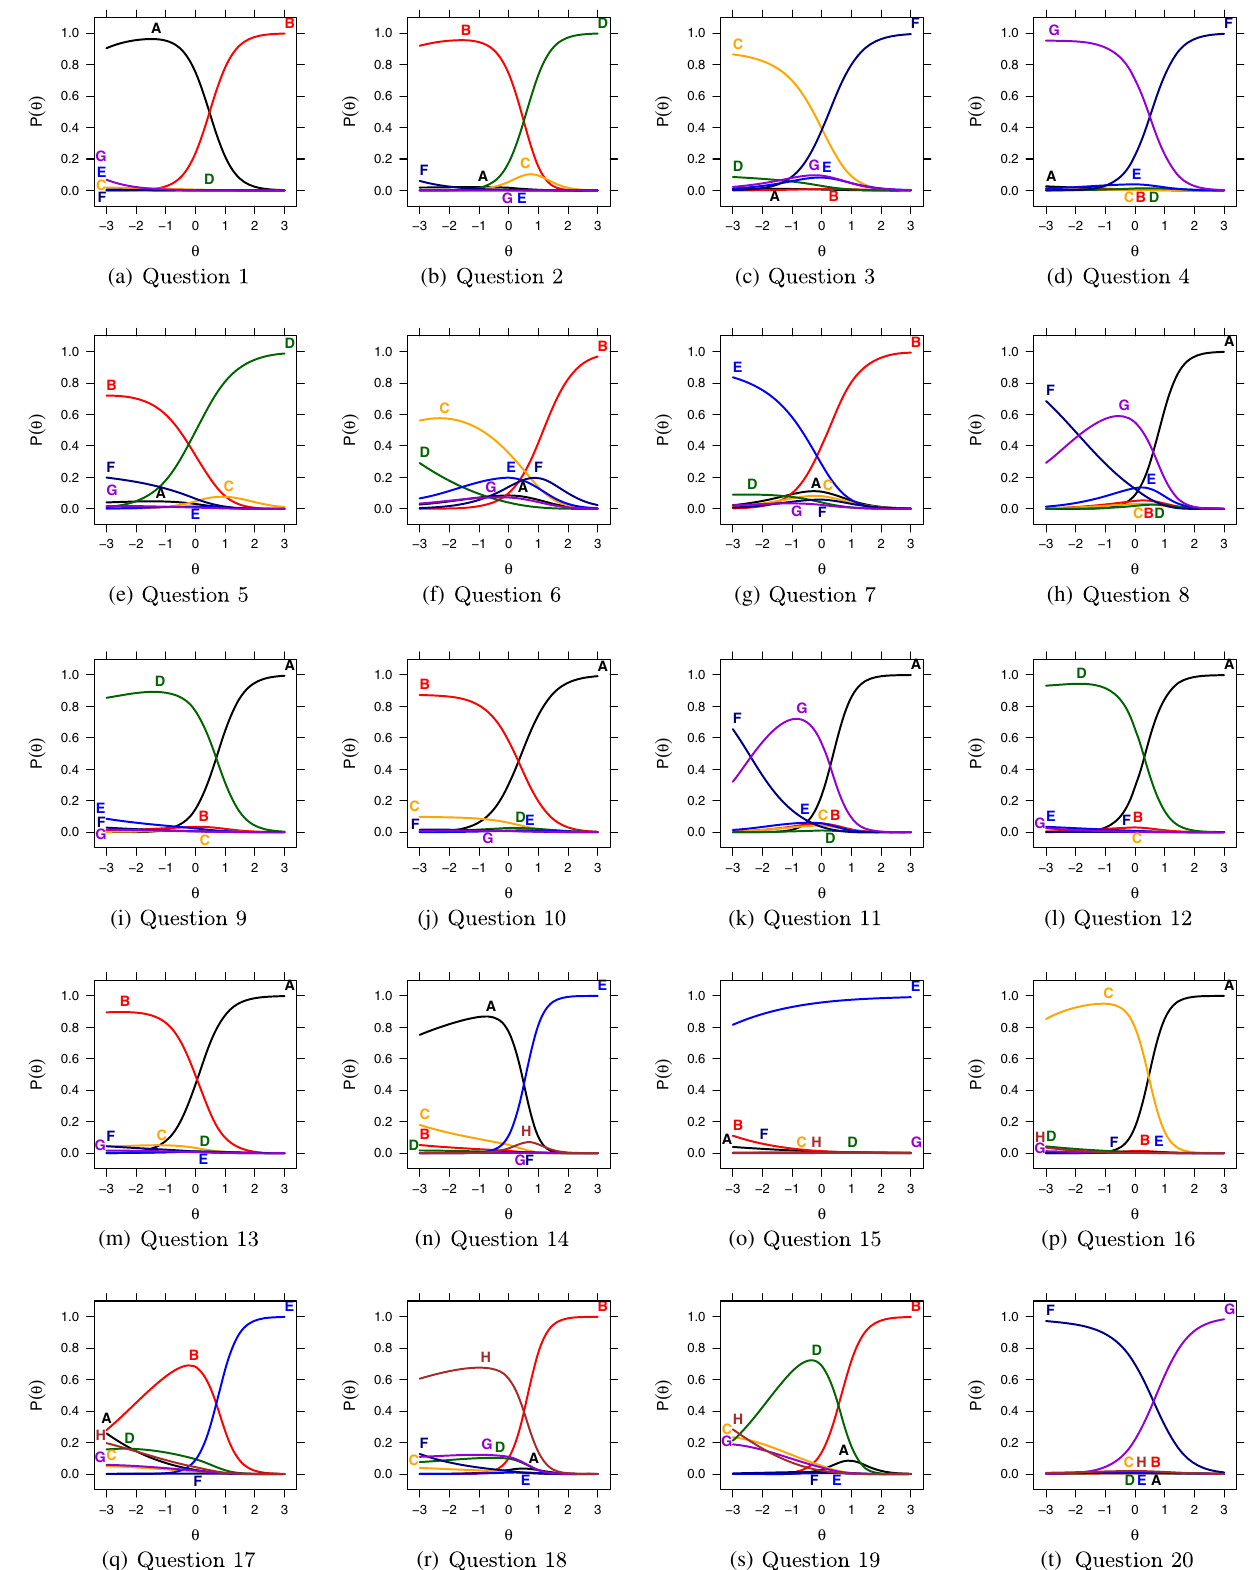
FIG. 6. IRT plots from the 2PL-NRM nested logit model for questions 1 – 20: Probability of choosing each response as a function of the person parameter θ (representing overall understanding of Newtonian mechanics). Plots created using the mirt and directlabels packages in R